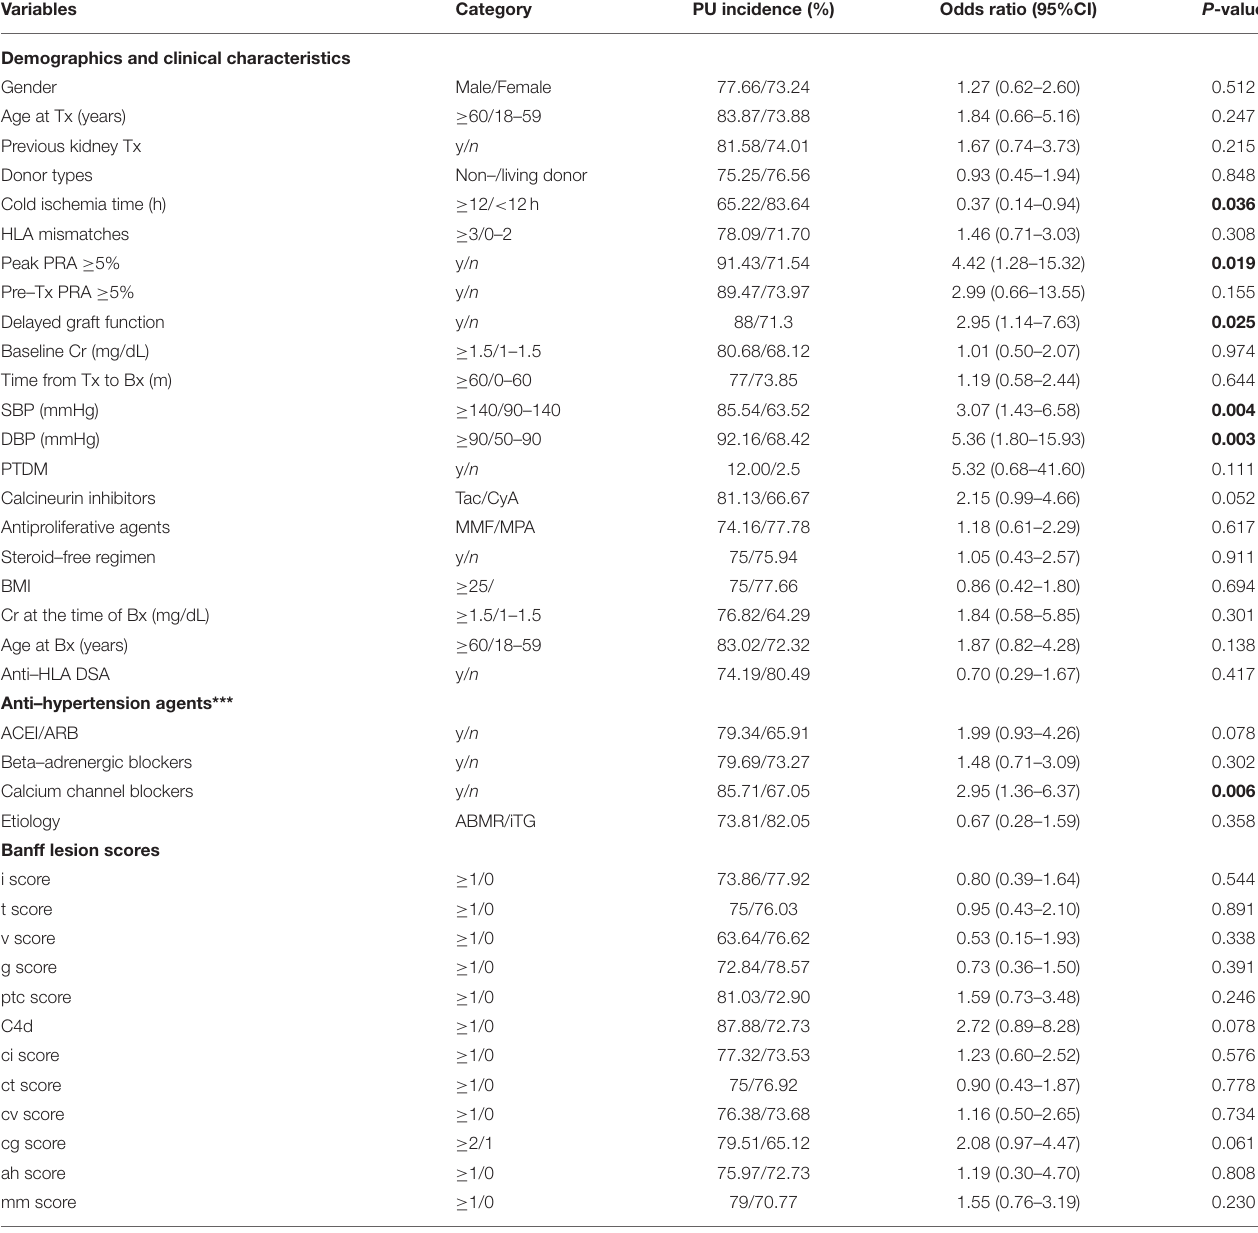
TABLE 4 | Univariable logistic regression analysis for the predictors of proteinuria.